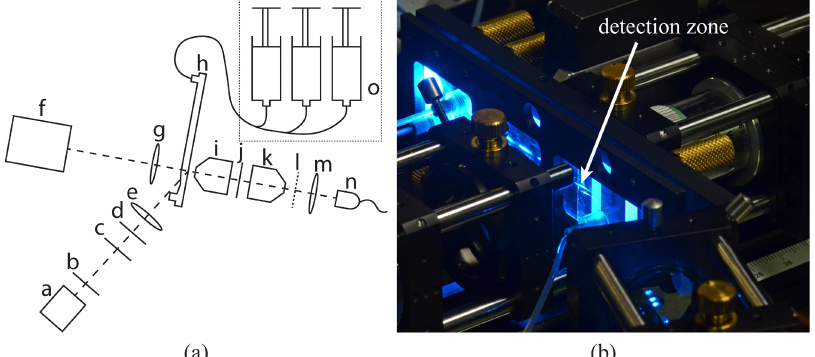
Figure 1. Experimental apparatus [9]: ( a ) Sketch of the experimental apparatus: (a) 488 nm laser, (b) iris diaphragm, (c) interference filter (laser clean- up), (d) λ/2 -plate, (e) cylindrical lens, (f) alignment camera, (g) spherical lens, (h) microfluidic chip, (i) and (k) microscope objective, (j) interference filter (high-pass), (l) spatially modulated mask, (m) spherical lens, (n) avalanche photo diode, (o) syringe pumps. ( b ) Microfluidic chip (h) installed in the experimental apparatus during measurement. The detection zone is located at the tip of the